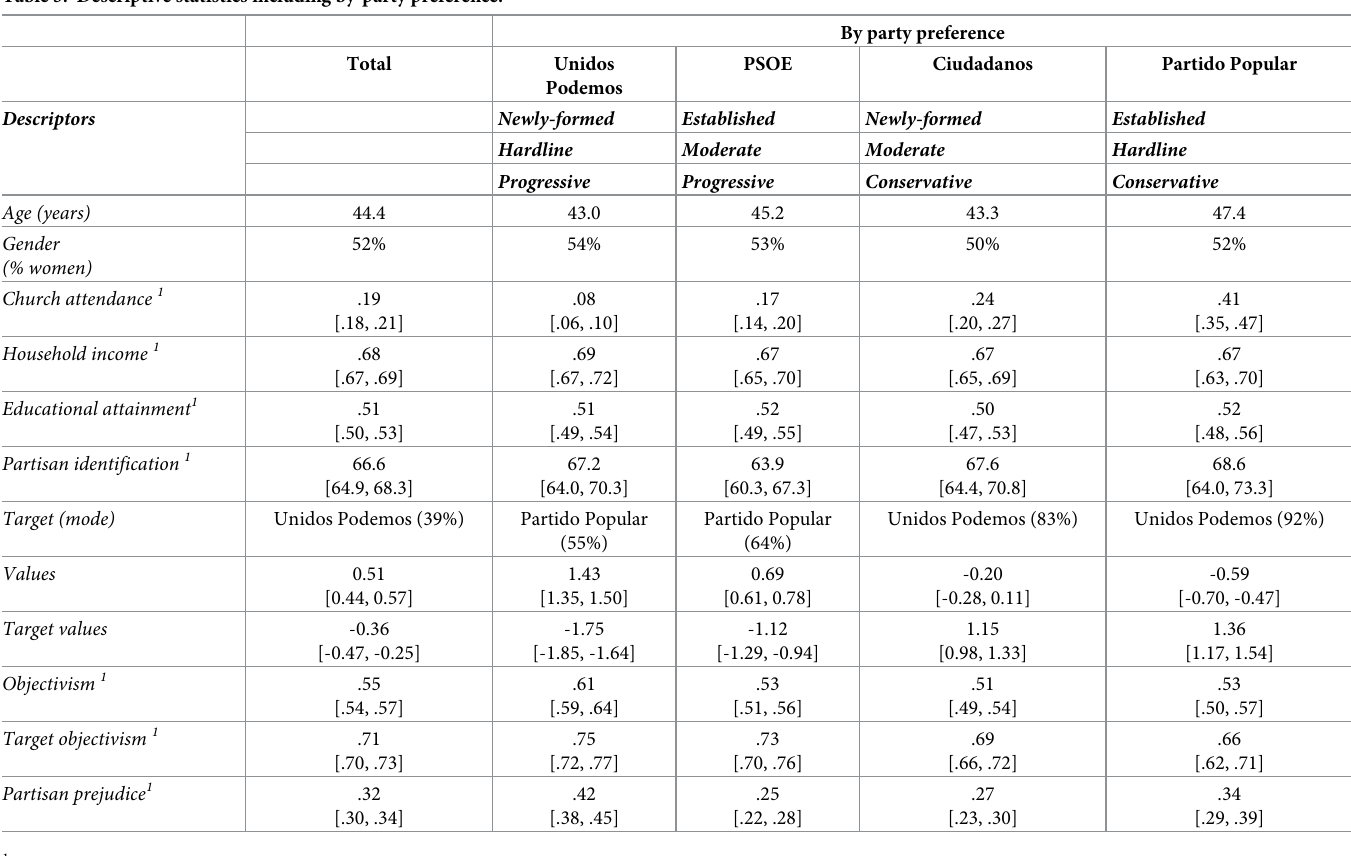
Table 3. Descriptive statistics including by-party preference.